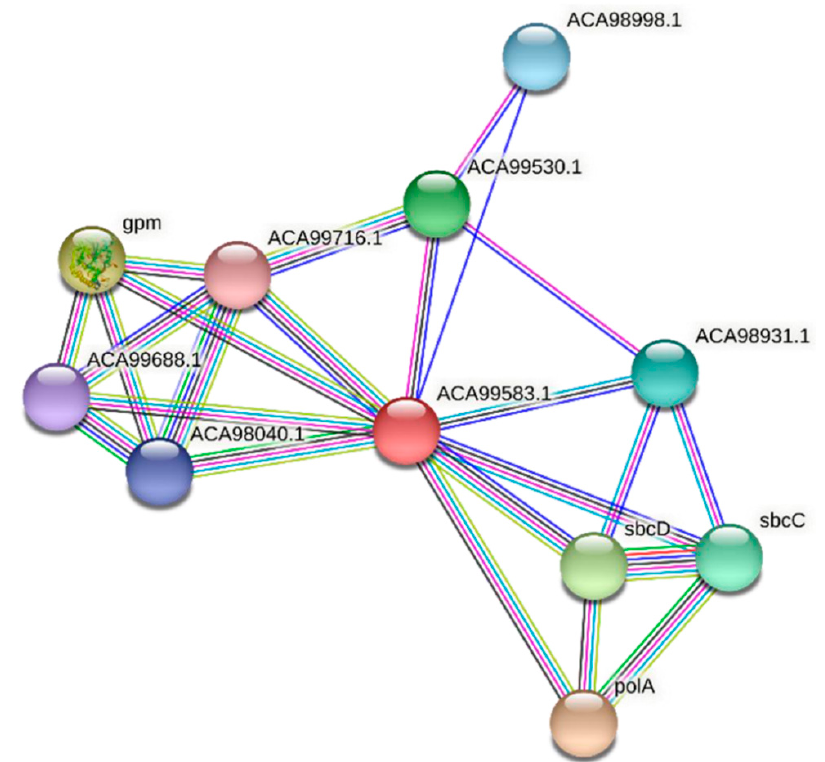
Figure 8. Protein–protein interaction network for PsoR homolog ACA99583.1 in Synechocystis sp.